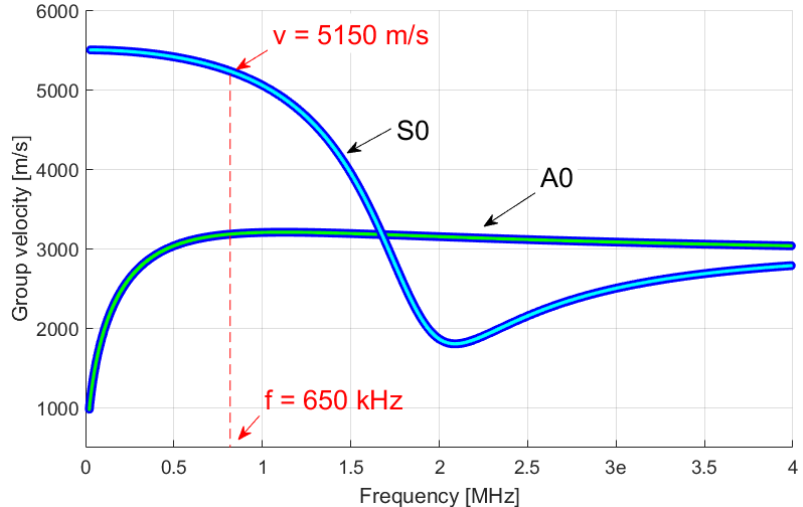
Figure 7. Viewgraph showing the calculated S 0 and A 0 group velocity dispersion curves for an aluminum plate with thickness of 1.4 mm.